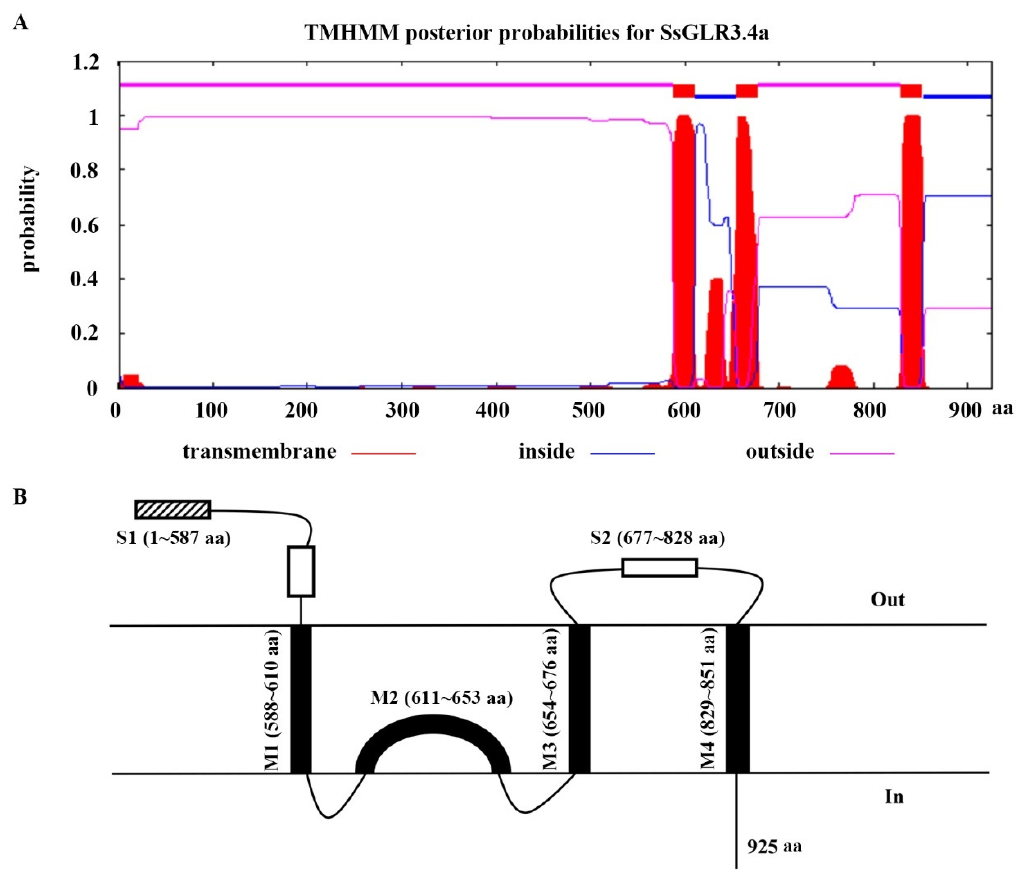
Figure 2. TMHMM transmembrane domain prediction ( A ) and topology structure ( B ), taking SsGLR3.4a as an example. ( A ) Inside represented the intracellular region, and the higher the value, the greater the probability that the amino acid was located in the intracellular region. Outside represented the extracellular region, and the larger the value, the greater the probability that the amino acid was located in the extracellular region. Transmembrane represented the transmembrane region, and the larger the value, the more likely that the amino acid was in the transmembrane region. ( B ) Visualize the topology based on ( A ) with three transmembrane domains (M1, M3, and M4), one M2 domain embedded in the lipid membrane, and two predicted ligand-binding regions S1 and S2 located on the lateral side of the cytoplasm, while “In” represented the intracellular region and “Out” represented the extracellular region.